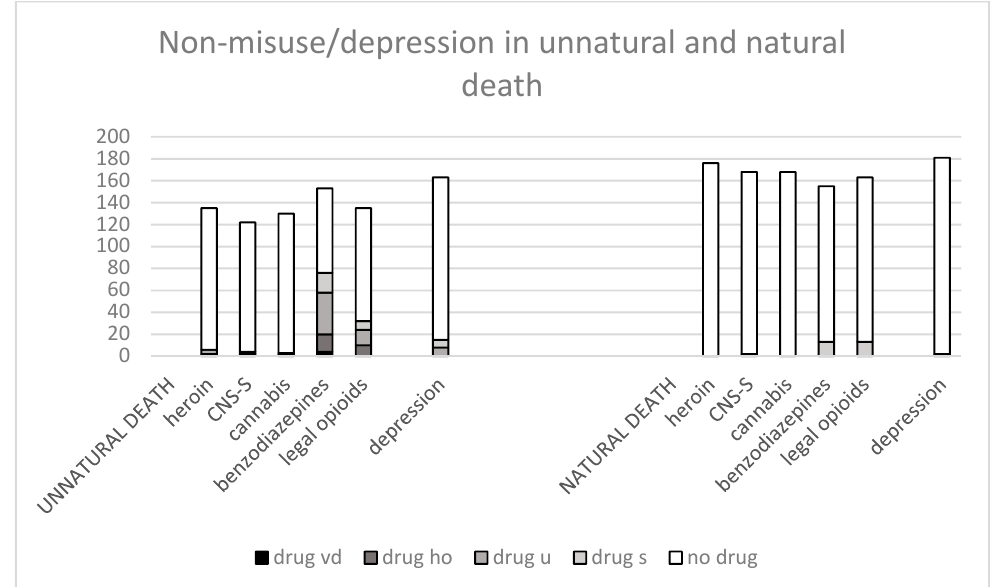
Figure 2. Autopsy findings by manner of death related to substances misused in life and previous depression; violent death (vd) heroin overdose (ho), undetermined intent (u) suicide (s), no drug. Unnatural and natural death. y-axis, number of cases.